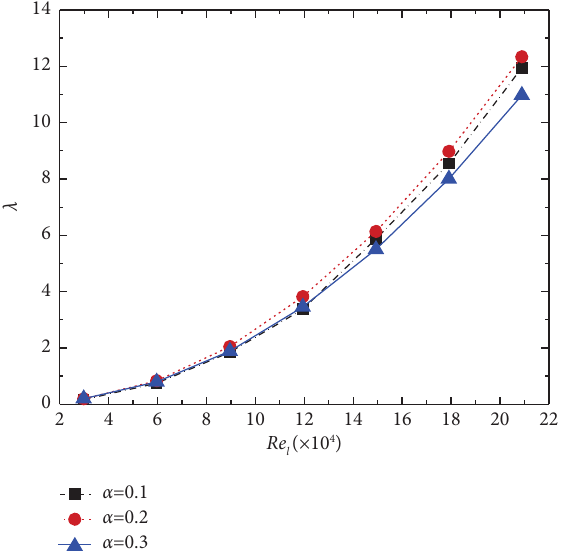
Figure 7: Relationship curves of λ with Rel under diferent α in vertical L-shaped pipes.